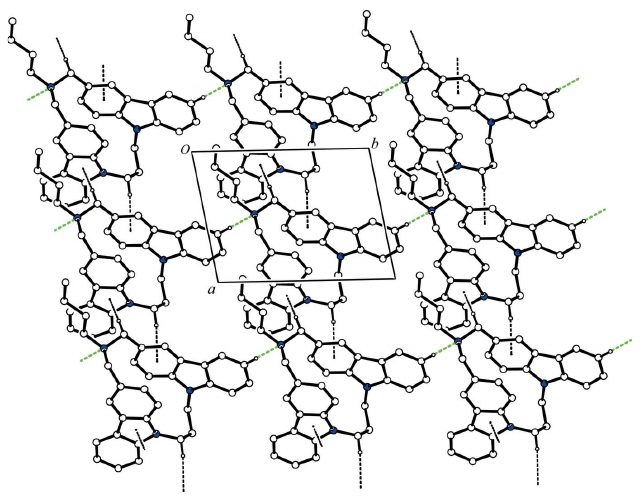
Figure 2 A packing diagram of the title compound viewed along the c axis, showing the two-dimensional network. The C—H (cid:2)(cid:2)(cid:2) N hydrogen bonds and C— H (cid:2)(cid:2)(cid:2) (cid:2) interactions are shown as green and black dashed lines, respectively. H atoms not involved in these interactions have been omitted for